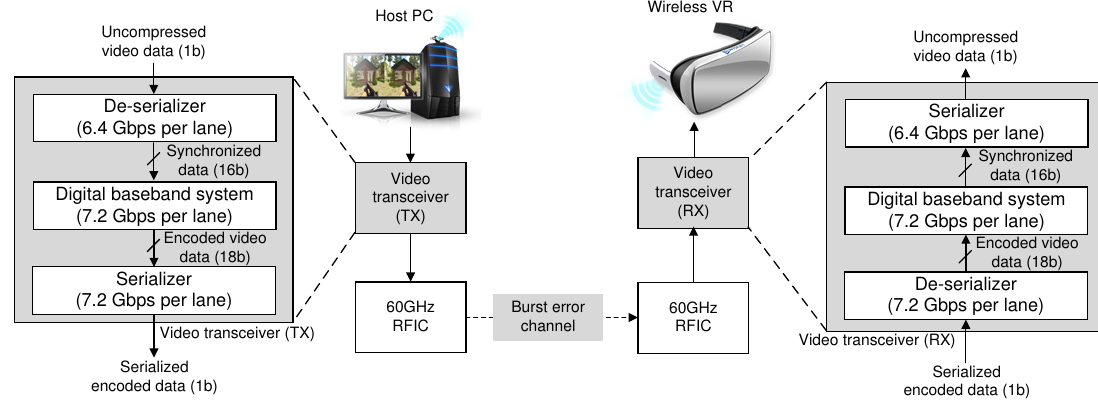
Figure 1. Processing flow of the proposed wireless VR system.